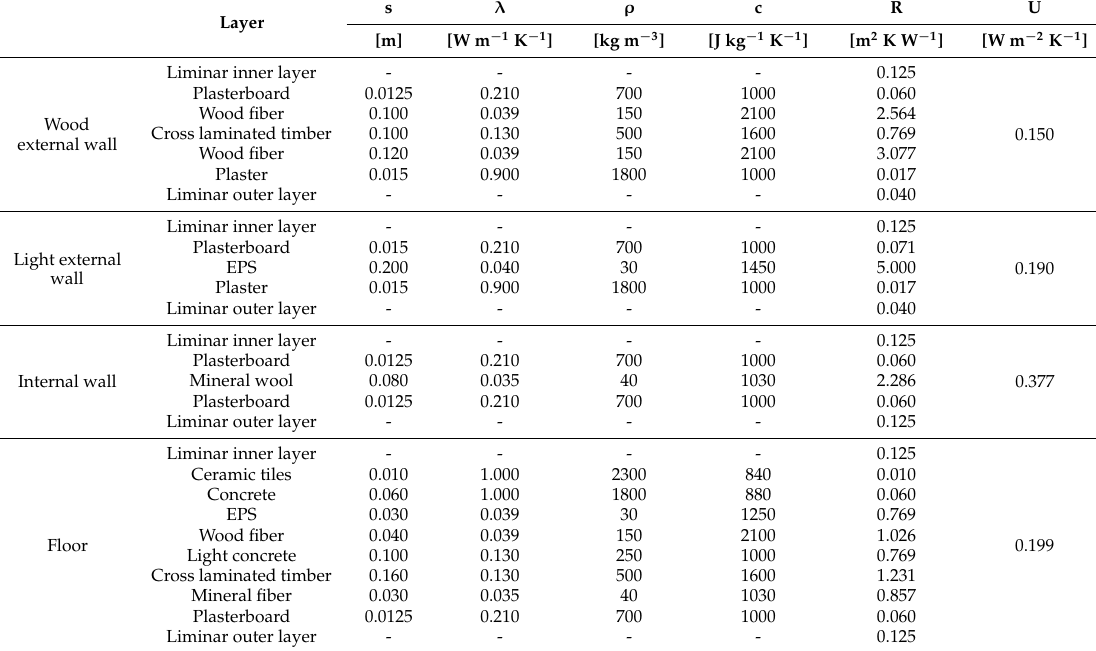
Table A4. Stratigraphy and thermal properties of the structures of the well-insulated, lightweight buildings (WIX and